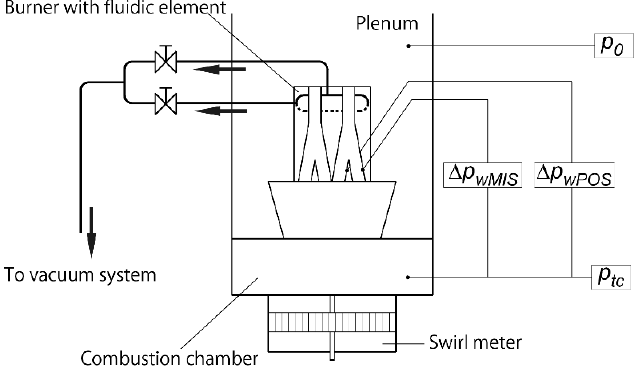
Figure 3. Experimental arrangement used for air-distribution measurement. (Copyright by ASME—“Effects of Fluidic Control of Air-Flow Distribution on Staged Lean Jet Engine Burner,” by Yoshida, Schneider, Hassa, Paper No: GT2016-57453).